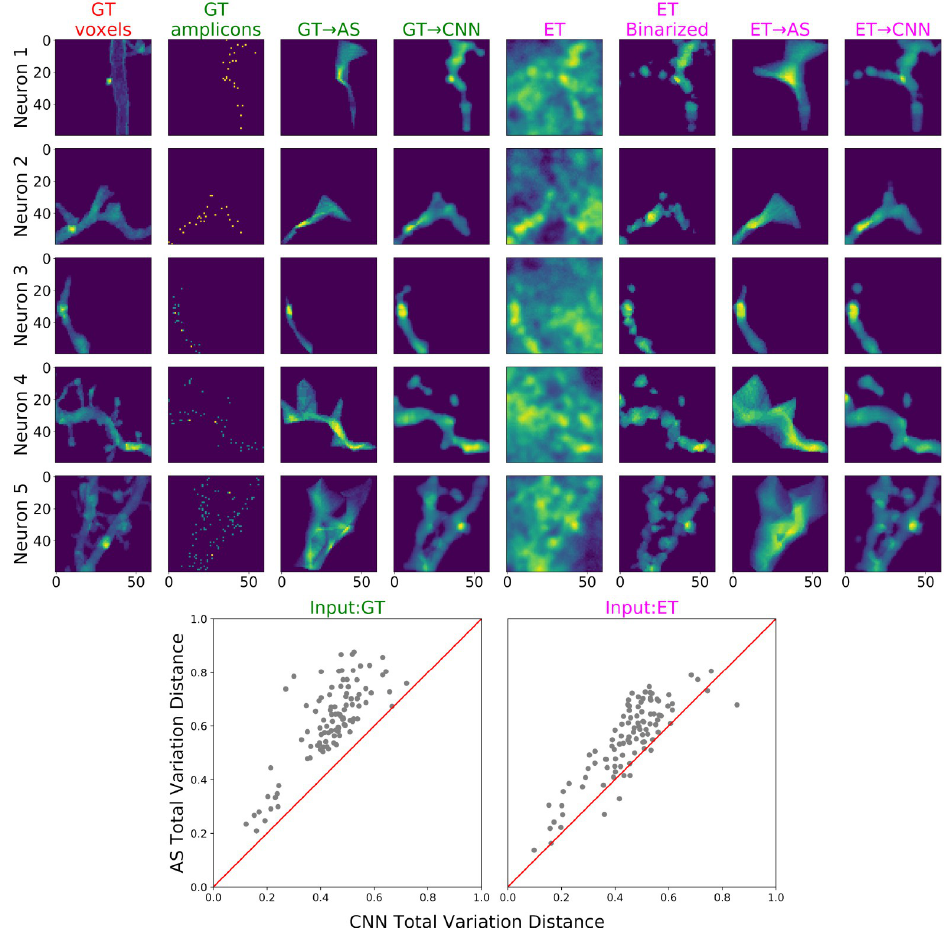
Fig 9. Comparing the morphology reconstruction for high-resolution, dense-expression simulations, using alphashape (AS) and CNN, with either ground-truth (GT) amplicons or evidence tensor (ET) as input. Top : Morphology prediction results for 5 examples. All the columns show the sum-projections across z-planes. The first column shows the ground-truth morphology. The next three columns show the prediction results using alphashape or CNN, when the ground-truth amplicons are used as input (indicated in green titles). The following four columns show the prediction results using alphashape or CNN, when the evidence tensors are used as input (indicated in magenta titles). Evidence tensors are first calculated using the correlation method described in S1A.3.1 Appendix, and before input into alphashape, they are binarized with threshold 0.7, as shown (again, see S1 Fig for details on the choice of this threshold). Bottom : Total variation distance (see S1A.3.2 Appendix) on 100 testing examples, including the five shown on the top panel, comparing the results from alphashape prediction on the input (y-axis) and CNN prediction on the input (x-axis). Each dot represents one testing example. The red lines indicate where the two methods have the same performance. Lower values are better; the CNN significantly outperforms the alphashape reconstructions here. A video of the reconstruction result (across z-planes) can be found at this